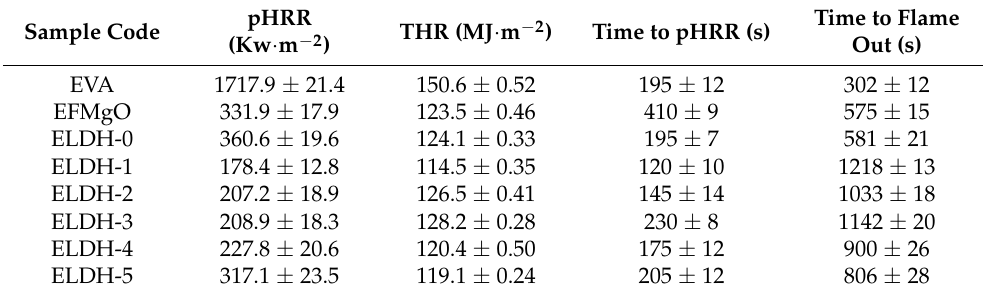
Table 2. Data from cone calorimeter